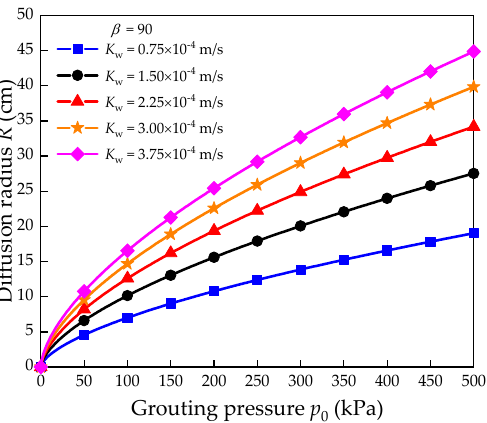
Figure 6. Influence of sand permeability coefficient on diffusion radius, which was drawn by Equa ‐ tion (44).